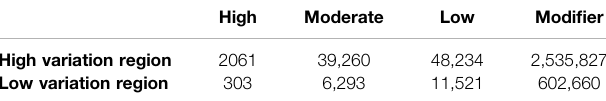
TABLE 5 | Impact of variants identi fi ed in high and low variation